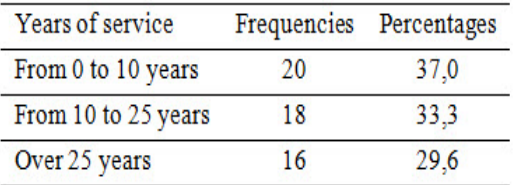
Table 3. Structure of the sample in rela -